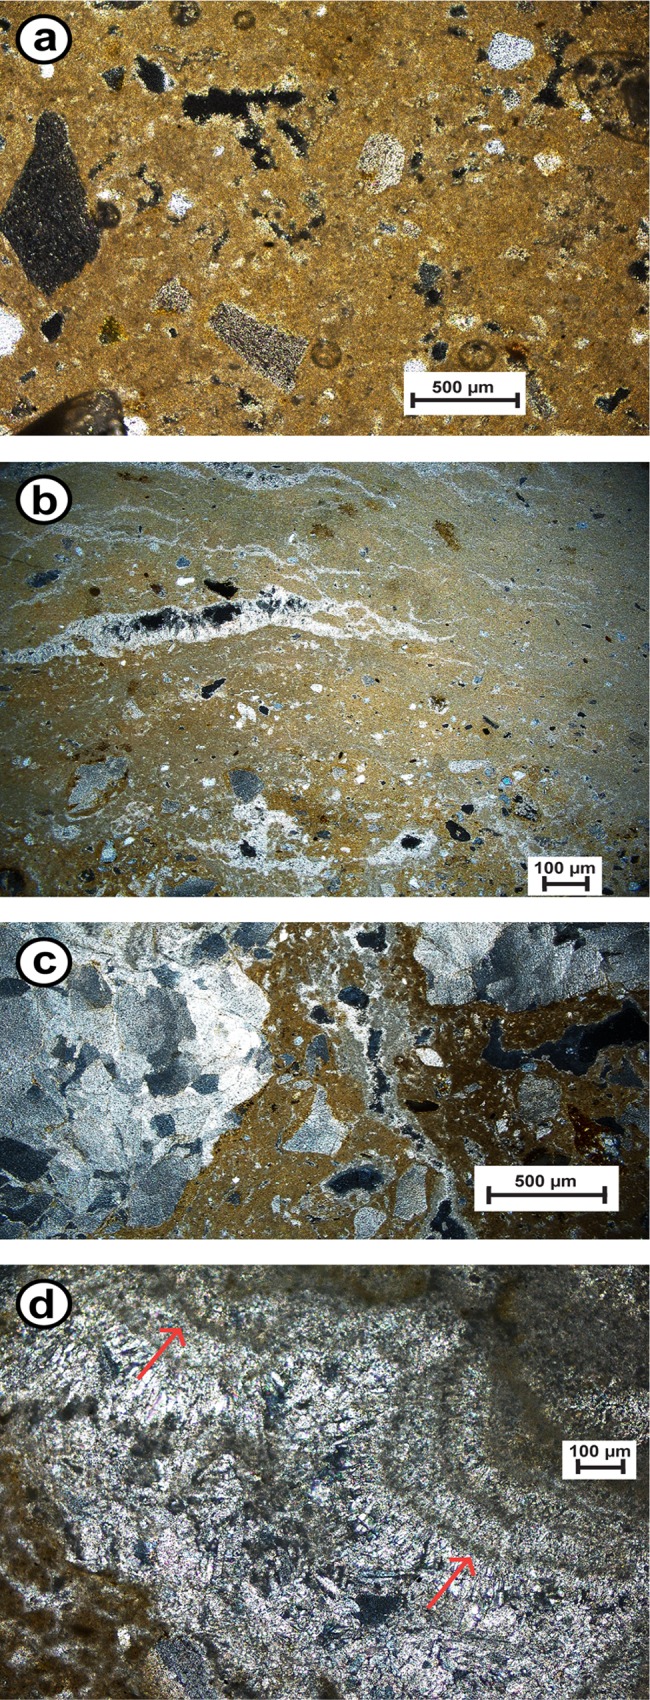
Thin section photographs.(a) Micritic calcrete with displaced semi-rounded lithoclasts and secondary porosity; (b) silcrete-calcrete intergrade duricrusts with silica crystals developed within stringers in the calcrete; (c) calcrete-silcrete intergrade duricrust with clear domination of silica cement over calcrete; (d) silcrete cements: amorphous brown opal followed by fibrous crystals of lussatite, also note the mammillary structured quartz crystals (arrows). All photographs were taken under cross-polarised light.